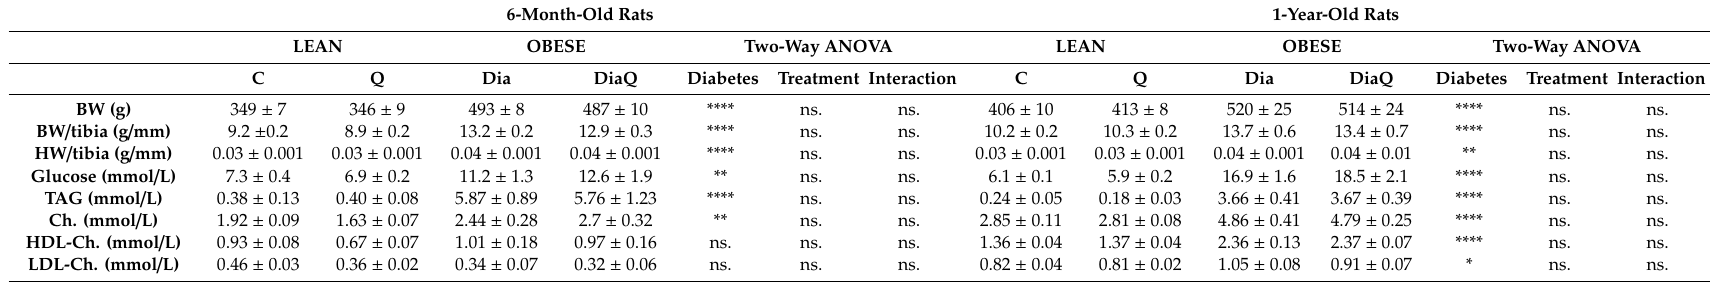
Table 1. Biometric and biochemical parameters of 6-month-old and 1-year-old ZDF